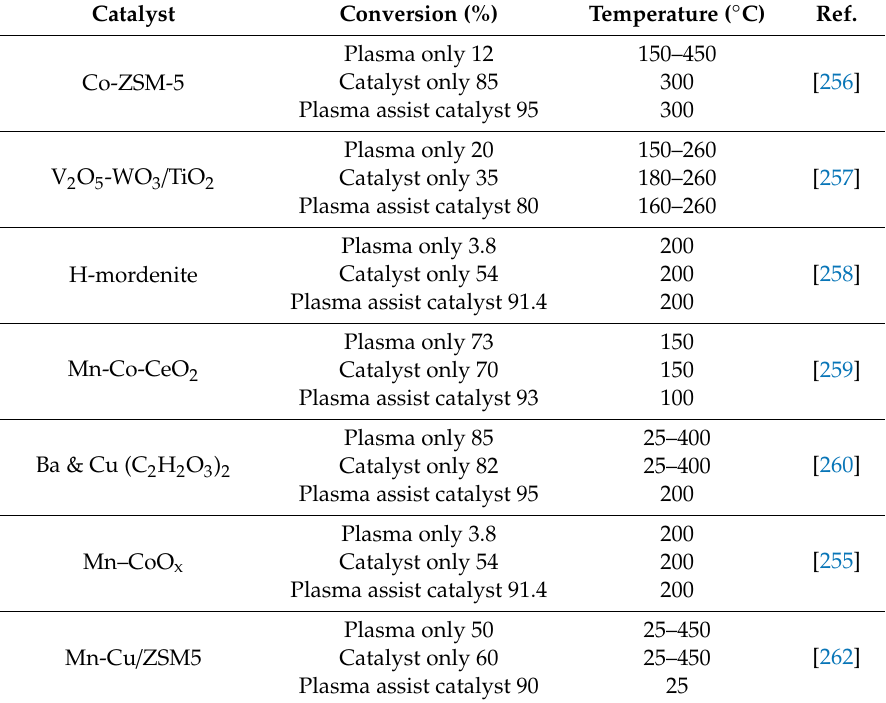
Table 7. E ff ect of plasma addition on denitrification activity of di ff erent